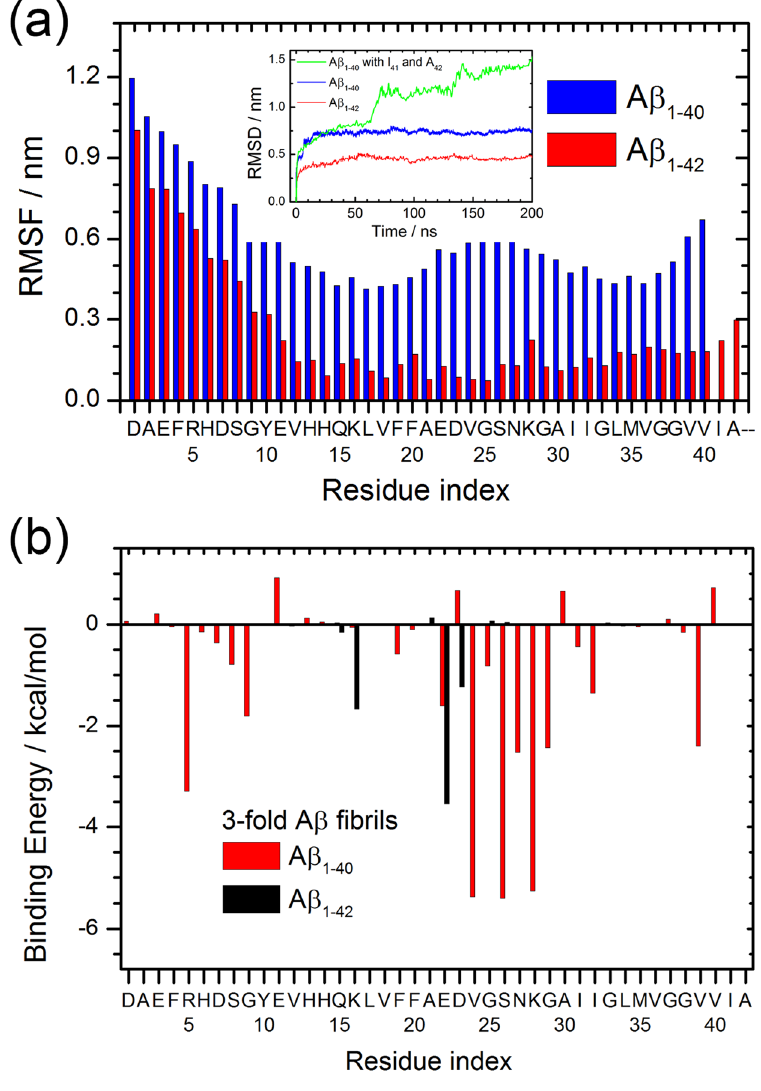
Figure 5. RMSF and binding energy of three-fold model. ( a ) Root-mean-square-fluctuations (RMSF) of residues in the three-fold A β 40 and A β 42 models. The inset shows for both models the root-mean-square- deviation (RMSD) to the start configuration as function of time. ( b ) Comparison of the binding energy of each residue for the two